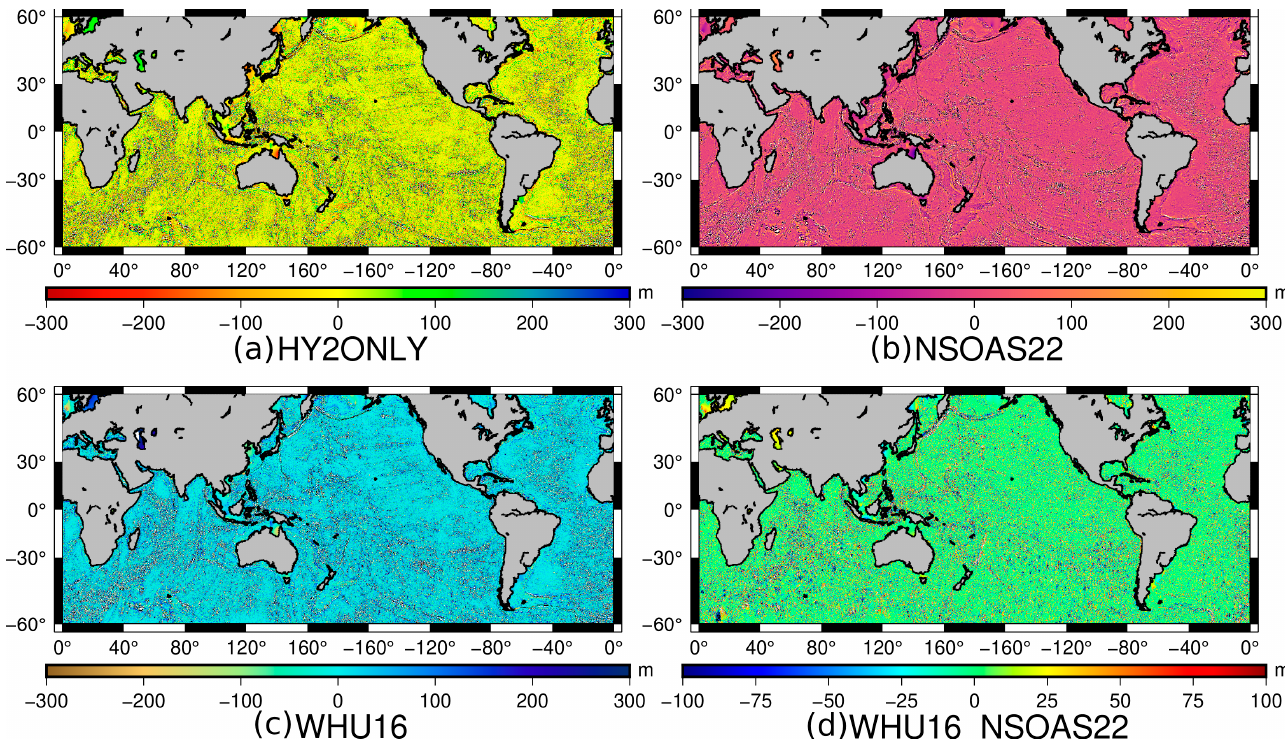
Figure 8. Error distribution of ( a ) HY2ONLY_BAT, ( b ) NSOAS22_BAT, ( c ) WHU16_BAT, and ( d ) the absolute error differences between WHU16_BAT and NSOASS22_BAT (WHU16_BAT absolute error minus that of NSOASS22_BAT).